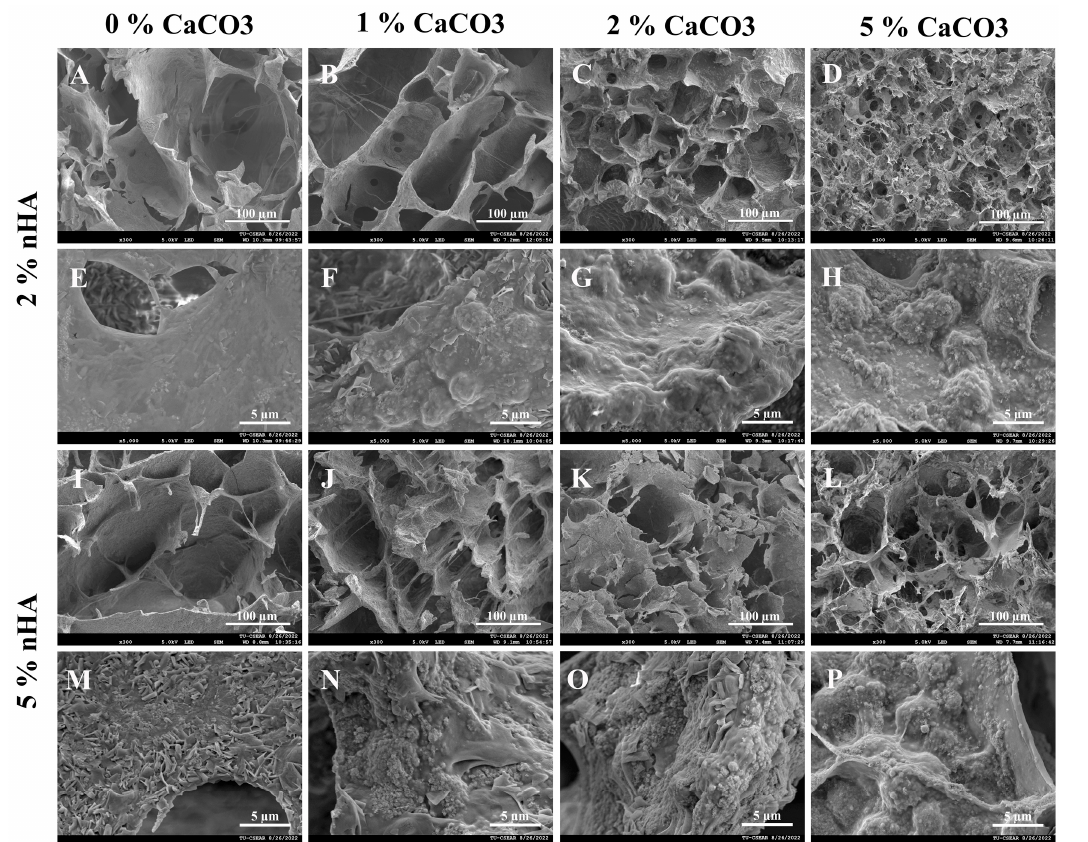
Figure 3. Scanning electron microscopy images exhibiting effects of calcium carbonate microcapsules (1%, 2%, and 5% ( w / v )) on microstructures and pore walls of the thermosensitive calcium carbonate microcapsule–2% and 5% ( w / v ) nanohydroxyapatite–10% ( w / v ) β -glycerophosphate–4:1 (w/w) chitosan/collagen (nHA–CaCO 3 –chitosan/collagen) hydrogels. Hydrogels with ( A , E , I , N ) 0% CaCO 3 , ( B , F , J , N ) 1% CaCO 3 , ( C , G , K , O ) 2% CaCO 3 , and ( D , H , L , P ) 5% CaCO 3 . Hydrogels with ( A – H )